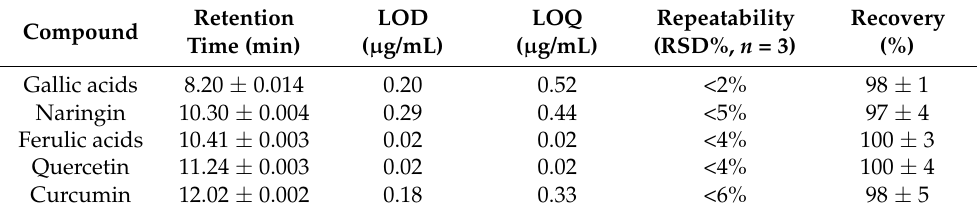
Table 3. Analytical figures of merit of HPLC-PAD method.